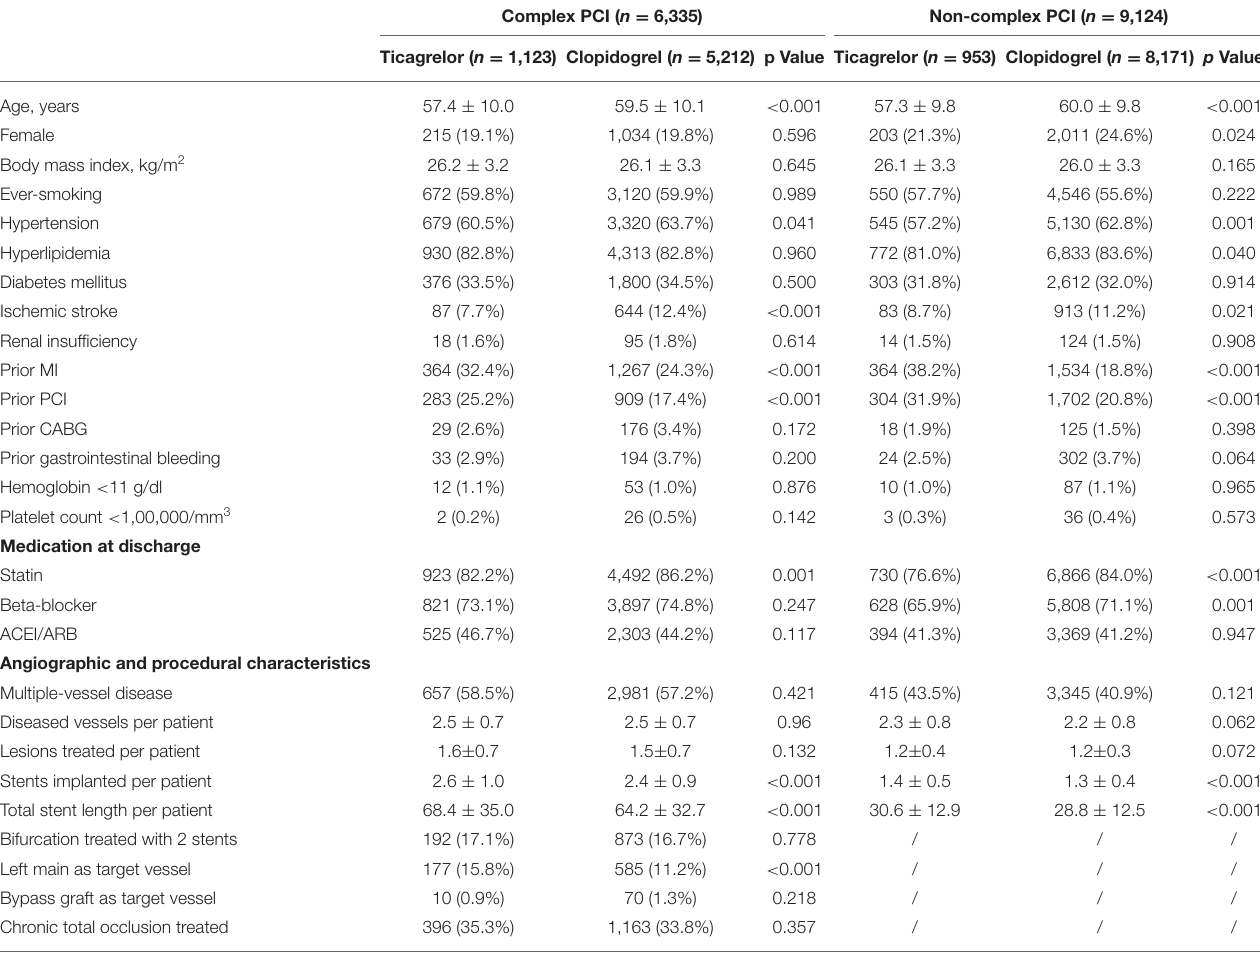
TABLE 2 | Baseline characteristics of patients treated with ticagrelor vs. clopidogrel in complex and non-complex PCI